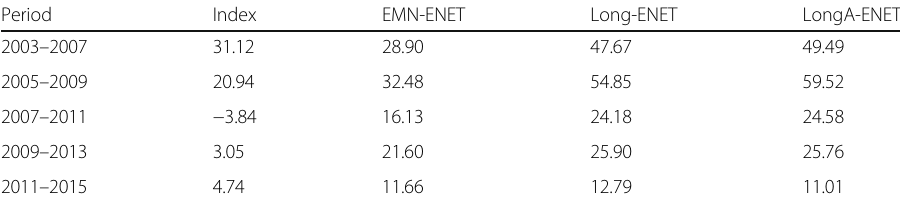
Table 5 Average annualized return over a 5-year rolling window